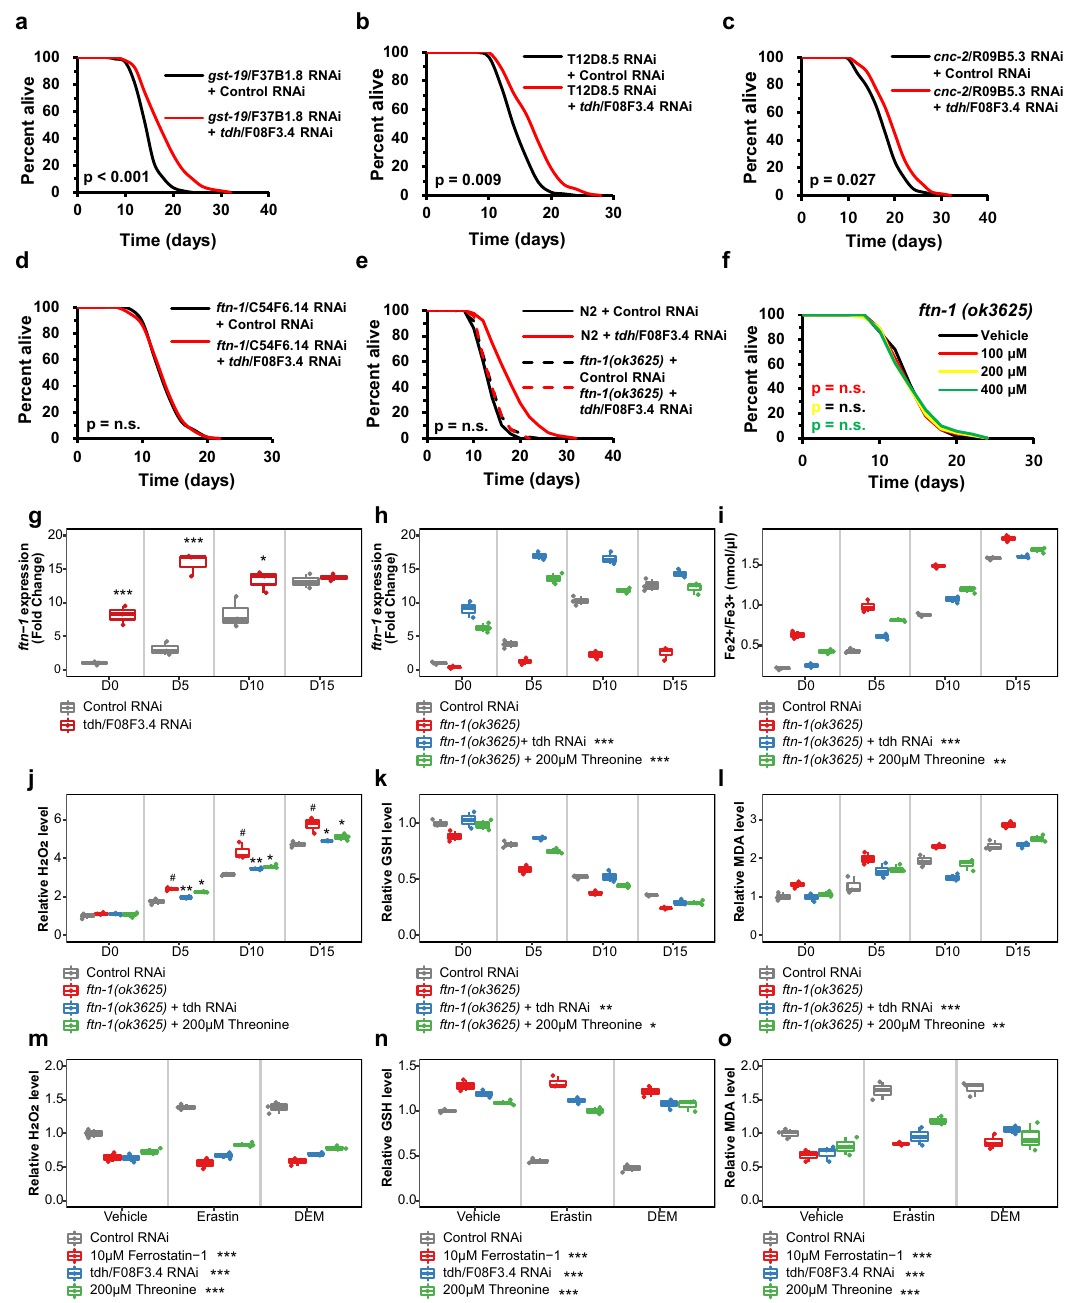
Fig. 4 | Increasing threonine manipulations upregulate expression of ferritin protein,FTN-1,andFTN-1-mediatedferroptosissuppression.a – d Lifespanassay of tdh/F08F3.4 RNAi(red)versus controlRNAi(black)with transcriptsof DAF-16 or HSF-1amongthecommonlyregulatedgenesof tdh/F08F3.4 RNAi,DR,and eat-2 (by Vennanalysis,SupplementaryData3),( a ) gst-19/F37B1.8 RNAi,( b ) T12D8.5 RNAi,( c ) cnc-2/R09B5.3 RNAi, and d ftn-1/C54F6.14 RNAi worms. e Lifespan assay of ftn- 1(ok3625) with tdh/F08F3.4 RNAi (red-dashed) versus control RNAi (black-dashed) compared with survival curves of N2 (bold-line). f Effects of threonine (100, 200, and 400 μ M) versus the vehicle (black) on lifespan of the ftn-1(ok3625) mutant. P value and lifespan assay data summarized in Supplementary Table 1. g Expression of ftn-1 under tdh/F08F3.4 RNAi was determined at intervals across lifespan (* p <0.05 and *** p <0.001 versus control RNAi, n =3 worm pellets). h Expression levels of ftn-1 under ftn-1 /C54F6.14 RNAi (# p <0.001 compared to control RNAi, *** p <0.001 versus ftn-1 RNAi, n =3 worm pellets). i Quanti fi cation of Fe 2+ /Fe 3+ iron contents of nematode with ftn-1 /C54F6.14 RNAi at intervals across lifespan (# p <0.001 compared to control RNAi, ** p <0.01 and *** p <0.001 versus the ftn-1